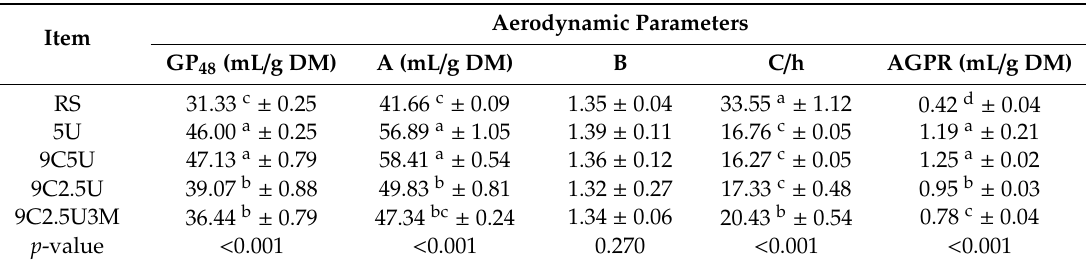
Table 5. E ff ect of ammoniation treatment on gas production of rice straw in vitro.